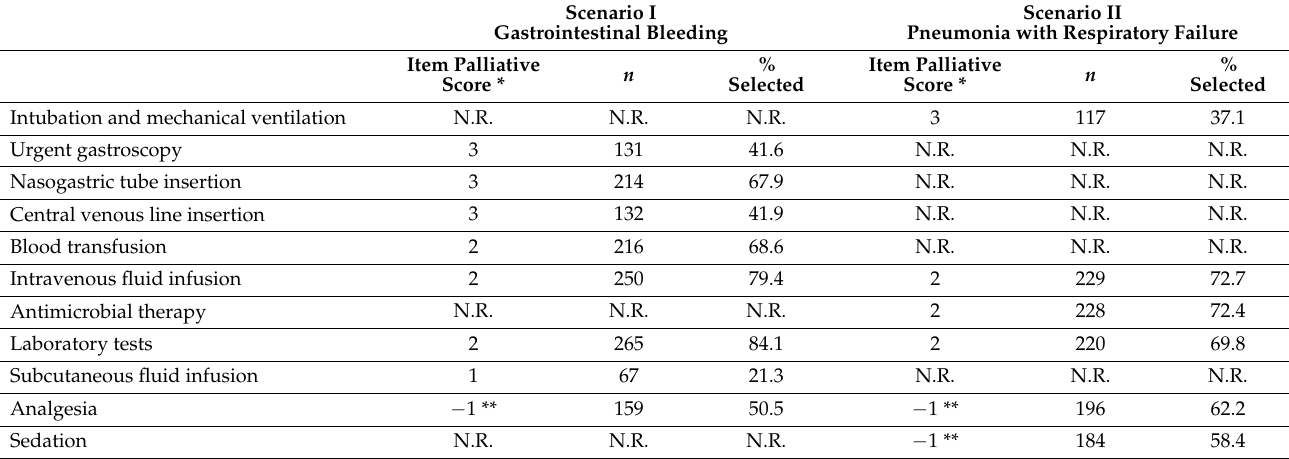
Table 2. Selected treatment options for case scenarios I and II ( n =